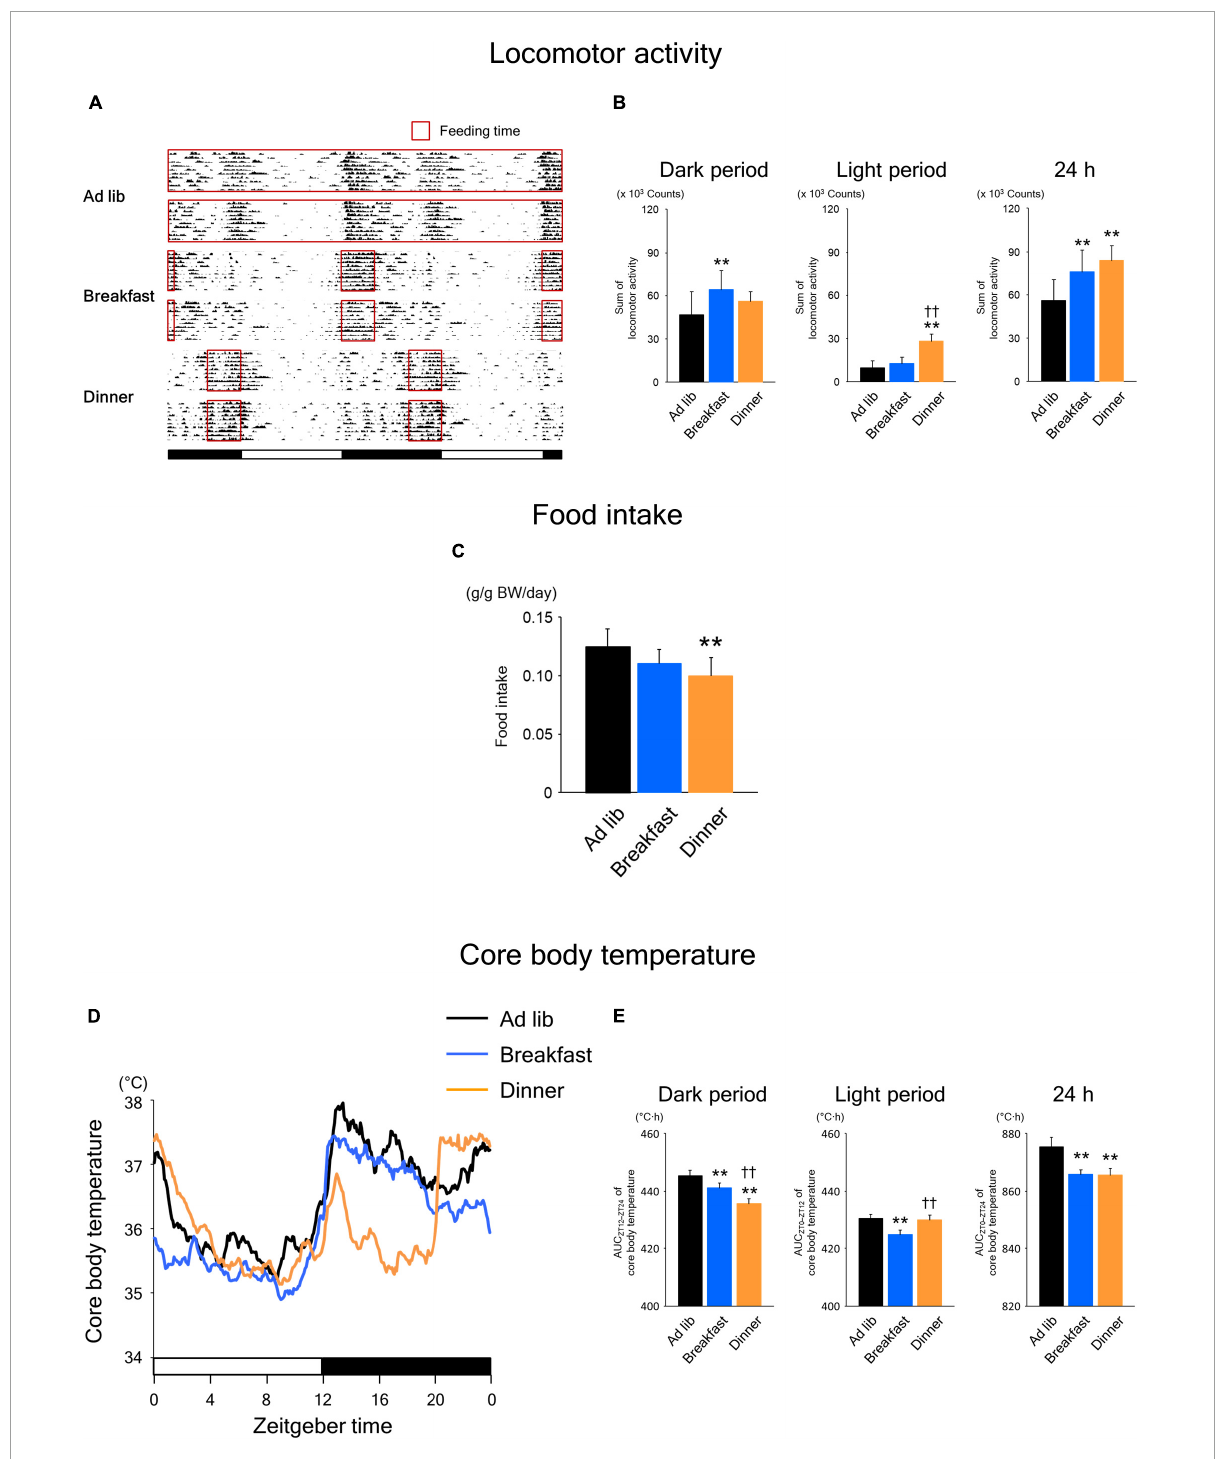
FIGURE2 Effects of time-restricted feeding on locomotor activity (A,B) , food intake (C) , and core body temperature (CBT) (D,E) in wild-type mice. (A) Representative double-plotted actograms of locomotor activity during days 8–18 ( n = 2 for each group). Red open boxed indicate feeding periods. Bottom white and black bars indicate light and dark periods, respectively. (B) Amounts of locomotor activity during the dark period, light period, and the total 24-h period. Data are means + SD of 15 values obtained from five mice. ** P < 0.01 vs. Ad lib; †† P < 0.01 vs. Breakfast. (C) Daily food intake. Data are means + SD of 10 values obtained from five mice. ** P < 0.01 vs. Ad lib. (D) Daily profiles of CBT. Data are means of 15 values obtained from five mice. (E) Area under the curve (AUC) of CBT during the dark period, light period, and the total 24-h period. Data are means + SD of 15 values obtained from five mice. ** P < 0.01 vs. Ad lib; †† P < 0.01 vs.